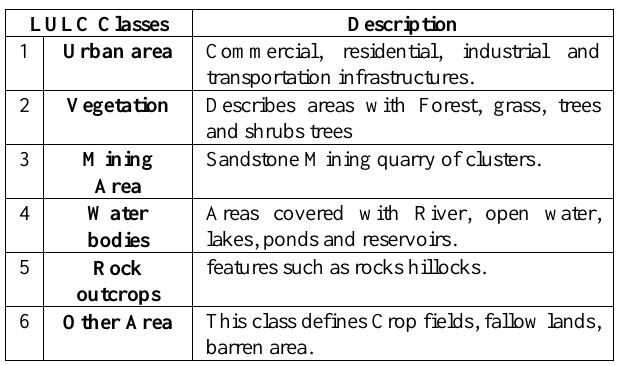
Table 4: LULC classification scheme.